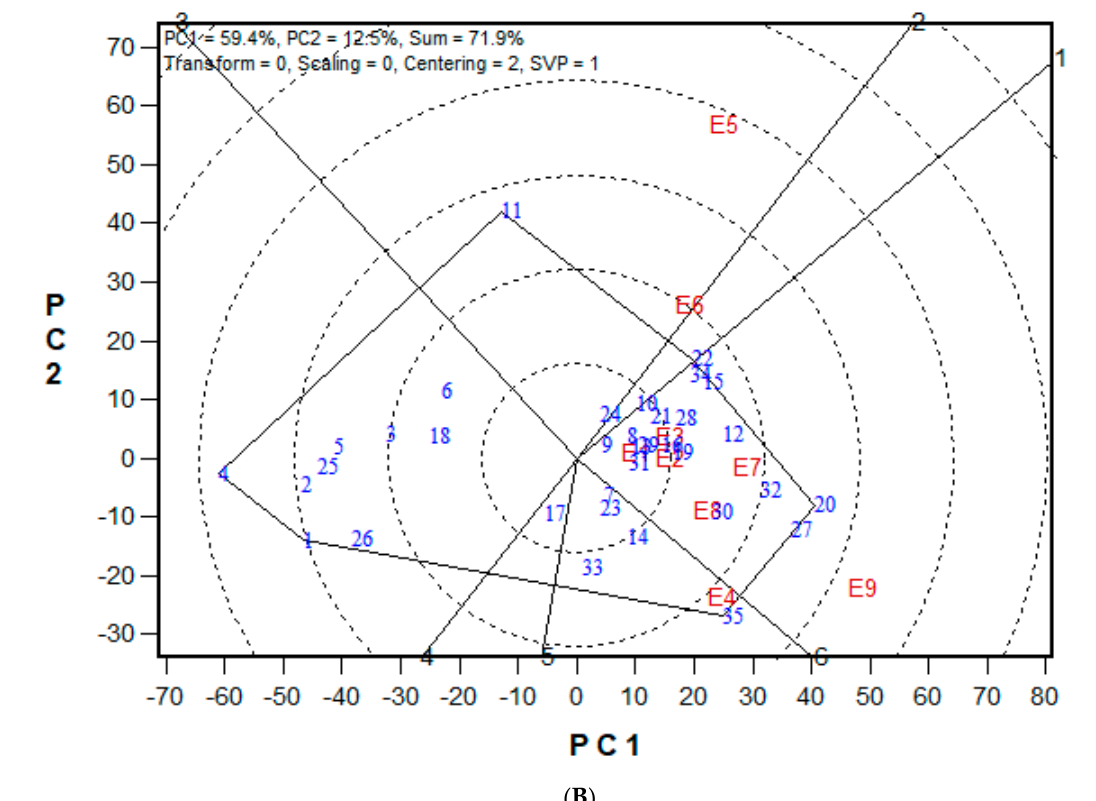
Figure 3. ( A ). A biplot display (mean vs. stability) based on genotype × environment data of 35 extra-early maturing hybrids assessed in 14 environments under drought and rainfed conditions from 2016 to 2019. E1 = Ikenne drought 16., E2 = Ikenne drought 18, E3 = Ikenne drought 19, E4 = Ikenne rainfed 16, E5 = Kano rainfed 16, E6 = Zaria rainfed 16, E7 = Ikenne rainfed 17, E8 = Bagauda rainfed 17, E9 = Zaria rainfed 17. ( B ). A Which-won where or what based on a genotype × environment yield data of 35 extra-early maturing hybrids evaluated across 14 environments (including drought and rainfed conditions) from 2016 to 2019.